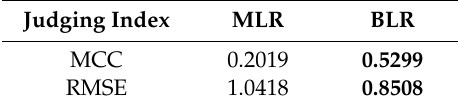
Table 16. Skill scores for the PC2 forecast by different models (bold font indicates the best performance). Table 15. Skill scores (in terms of the multiple correlation coe ffi cient (MCC) and root mean square error (RMSE)) for the PC1 forecast by di ff erent models (bold font indicates the best